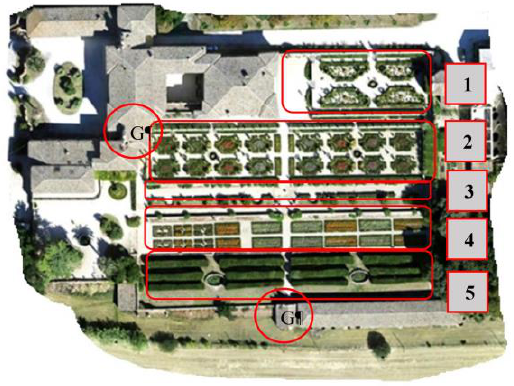
Figure 2. The subdivision of the Italian Garden in terraces